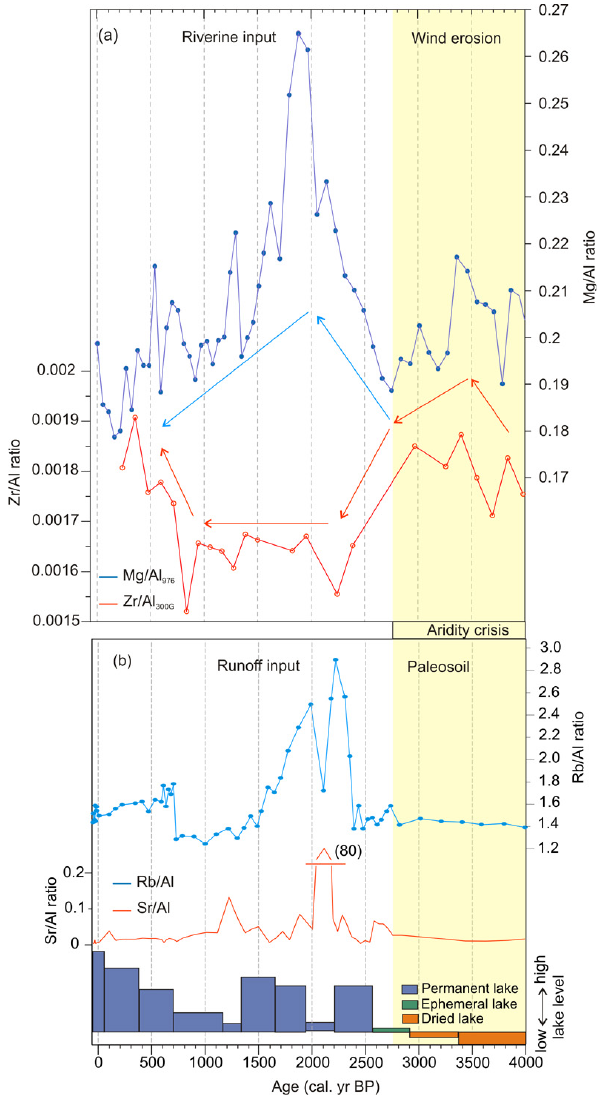
Fig. 2. (a) Alboran paleoenvironmental proxies: in blue, Mg/Al ratio from core ODP976 sediments as indicator of Iberian riverine inputs into the Alboran basin; in red, Zr/Al ratio from core 300G as Saharan dust inflow. (b) Zo˜nar paleoenvironmental proxies: in blue, Rb/Al ratio as detrital input into the lake; in red, Sr/Al ratio as ion water concentration (Mart´ın-Puertas et al., 2009); and lake level reconstruction from multiproxy analyses published in Mart´ın- Puertas et al.